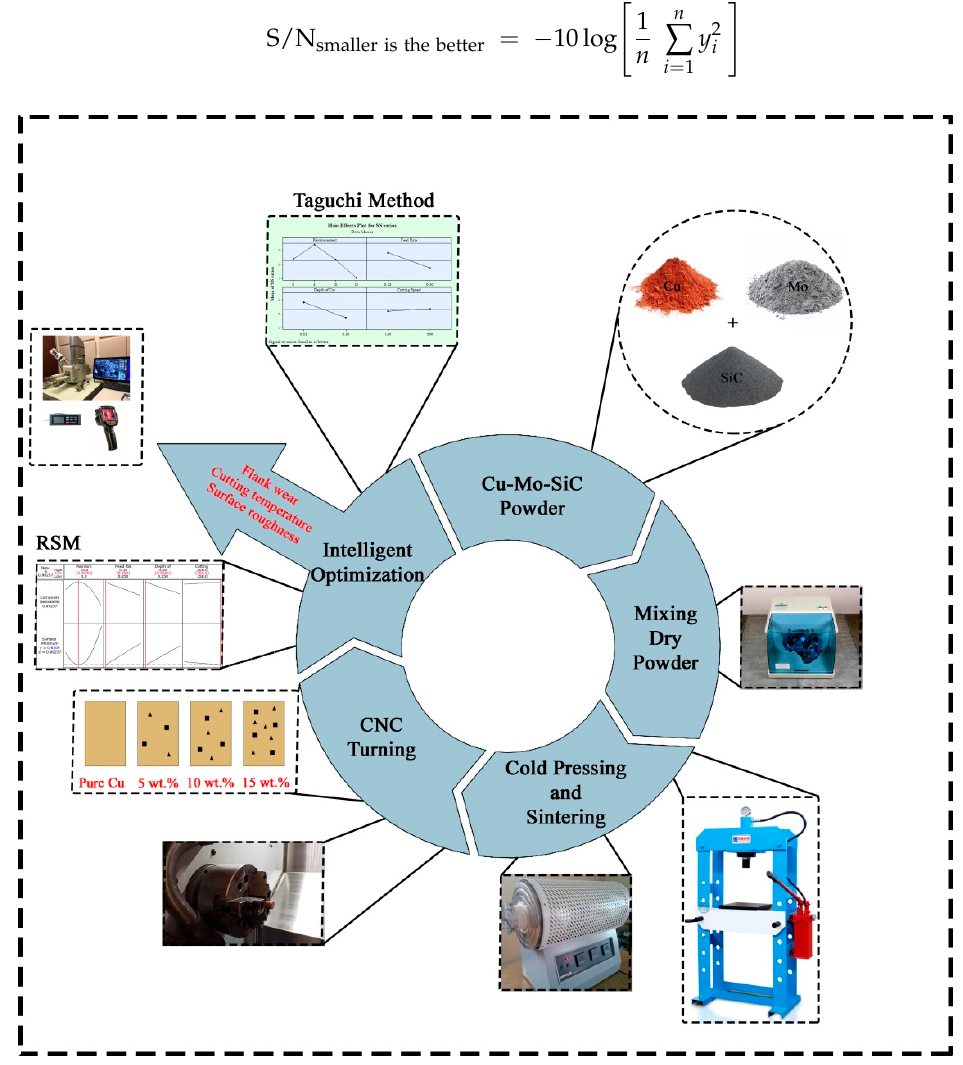
Figure 1. Experimental setup.